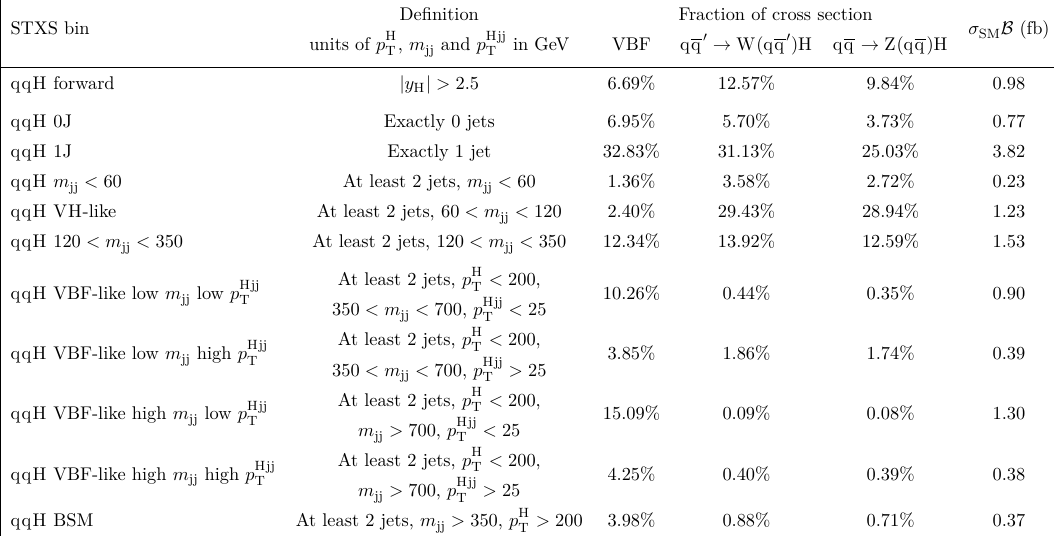
Table 4 . Definition of the qqH STXS bins. The product of the cross section and branching fraction √ ( B ), evaluated at = 125 GeV, is given for each bin in the last column. The s = 13 TeV and m H fraction of the total production mode cross section from each STXS bin is also shown. Unless stated otherwise, the STXS bins are defined for | y | < 2 . 5 . Events with | y | > 2 . 5 are mostly outside of H H the experimental acceptance and therefore have a negligible contribution to all analysis